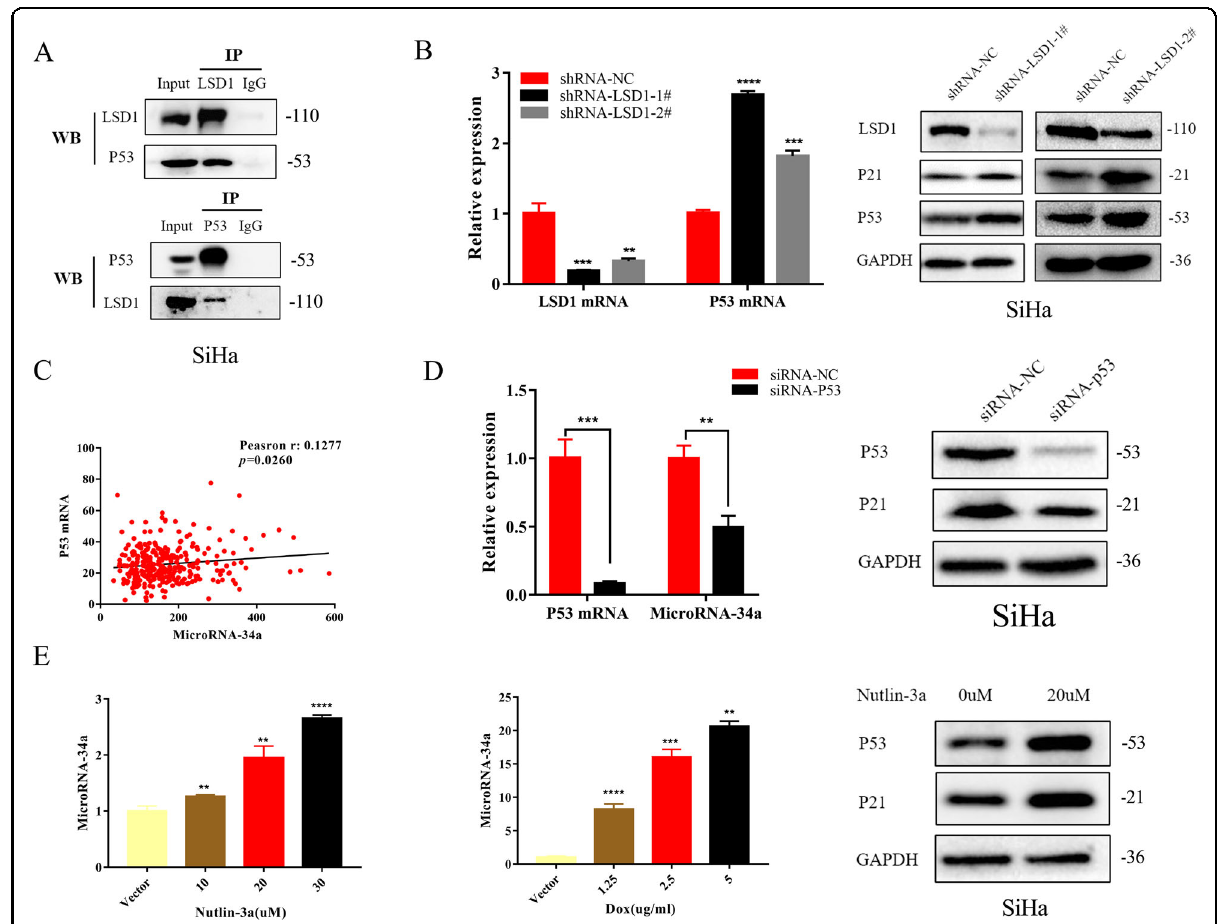
Fig. 5 LSD1 silencing increased miR-34a expression through targeting wild-type p53. A Co-IP assay showed that LSD1 formed a stable complex with wild-type p53 in SiHa cells. B LSD1 knockdown contributes to upregulation of p53 mRNA and protein expression in SiHa cells ( n =